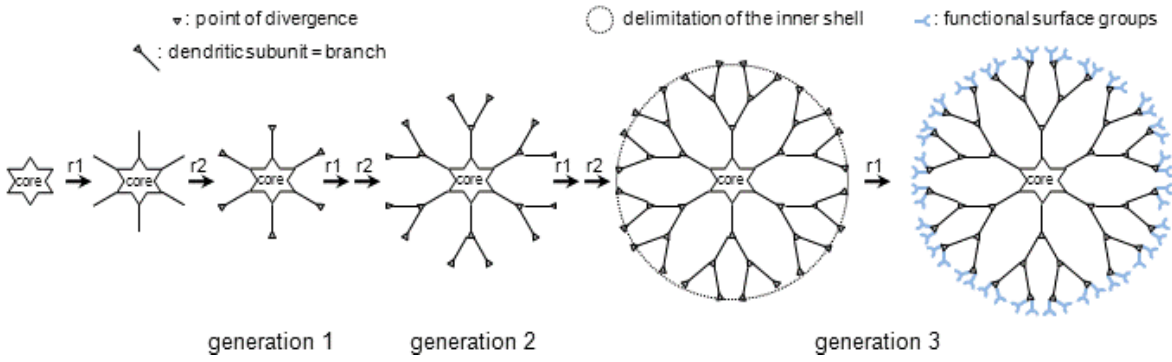
FIGURE 1. Scheme of the divergent synthesis route of a generation 3 dendrimer. r1 and r2 are the iterative